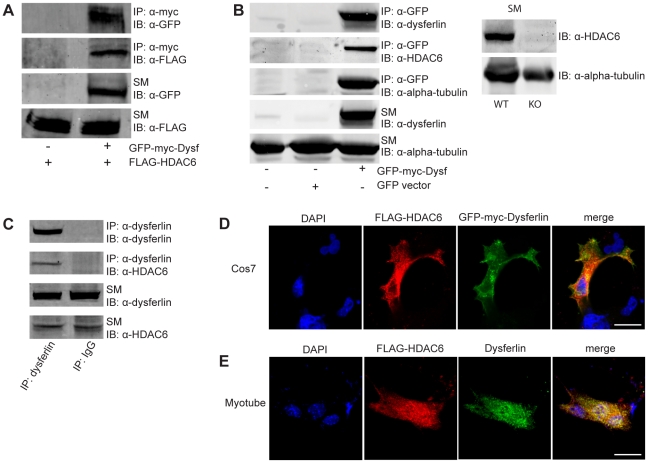
Dysferlin co-immunoprecipitates with HDAC6.(A) HEK293T cells were transfected with GFP-myc-dysferlin (GFP-myc-Dysf) and FLAG-HDAC6, and recombinant dysferlin was immunoprecipitated (IP) with anti-myc antibodies. Immunoprecipitates were separated by SDS-PAGE and immunoblotted (IB) with the indicated antibodies. SM = starting material, 5% of total protein loaded. (B) GFP-myc-dysferlin (GFP-myc-Dysf) or GFP vector were transfected in HEK293T cells, immunoprecipitated with anti-GFP antibodies and incubated with testes homogenate from wildtype C57Bl/6 mice, which is a rich source of HDAC6. Immunoprecipitates were immunoblotted with the indicated antibodies. Alpha-tubulin was used as a loading control. (Right panel) HDAC6 protein levels in testes of wildtype C57Bl/6 mice (WT) versus HDAC6 knockout mice (KO), which were immunoblotted with anti-HDAC6 antibodies to demonstrate the specificity of the detected band. (C) Native dysferlin was immunoprecipitated with anti-dysferlin antibodies in mouse skeletal muscle extracts. Immunoprecipitates were separated by SDS-PAGE and immunoblotted with anti-dysferlin and anti-HDAC6 antibodies. (D) GFP-myc-dysferlin and FLAG-HDAC6 were overexpressed in Cos7 cells. Cells were fixed and immunostained with anti-GFP and anti-FLAG antibodies. (E) 134/04 cells were transfected with FLAG-HDAC6 and differentiated into myotubes. Cells were fixed and immunostained with anti-dysferlin and anti-FLAG antibodies. Scale bar: 20 µm.